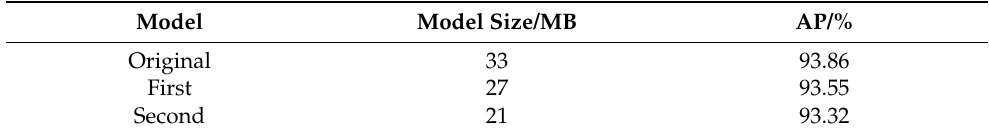
Table 2. Model results of twice pruning.